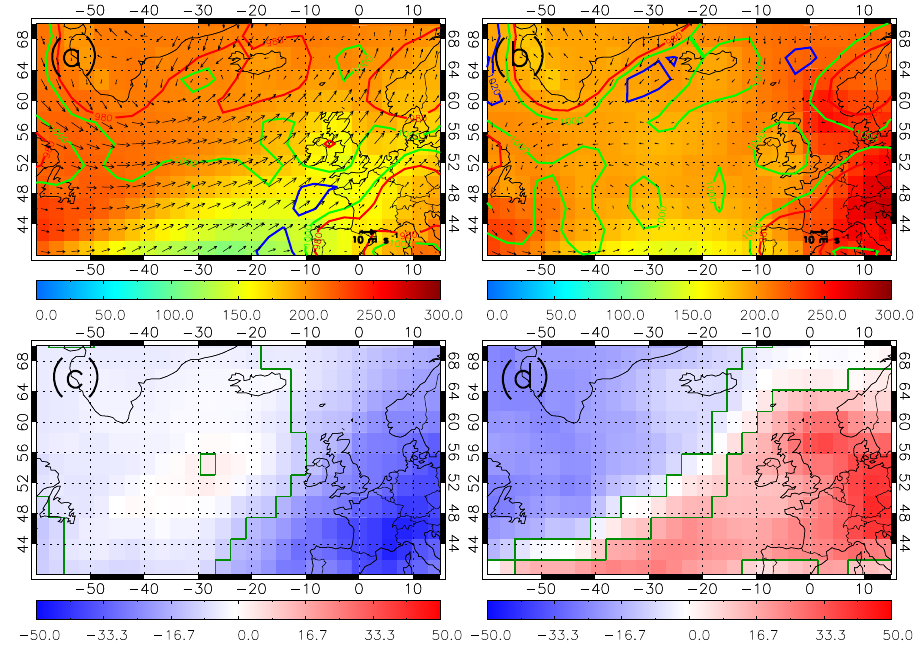
Figure 9. TOMCAT surface PAN (pptv) averaged between 2006 and 2015 sampled under the wintertime (NDJF) NAO. Panel (a) NAO positive phase, (b) NAO negative phase, (c) shows the NAO positive phase anomaly relative to the wintertime average and (d) shows the negative NAO phase anomaly relative to the wintertime average. Wind vectors show the horizontal 10m winds and the red, green and blue contours represent 980, 1000 and 1020hPa surface pressure. Green polygon-outlined regions in (c) and (d) highlight significant differences at the 95% confidence level based on the WRT.